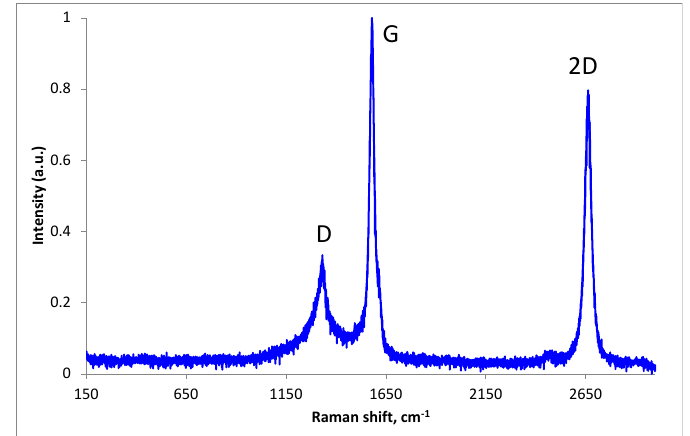
Figure 4. HRTEM characterization of the Cu nanoparticles in the GrCu2 sample: ( a ) elemental mapping of copper (red)-scale bar 100 nm and ( b ) HRTEM image of Cu nanoparticles mostly encapsulated in carbon graphitic shells—scale bar 5 nm.